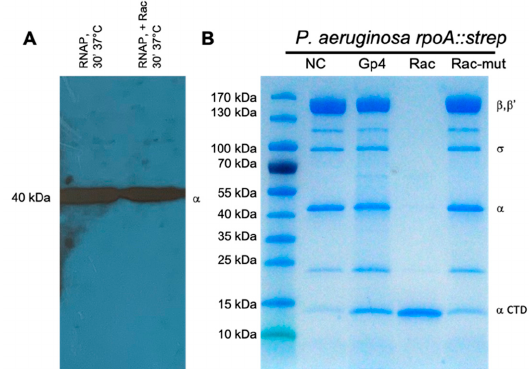
Figure A4. Rac does not have protease activity and the predicted N -acetyl CoA binding pocket of Rac is required for cleavage. ( A ) Recombinant Rac was incubated at 37 ◦ C for 30 min with P. aeruginosa RNAP purified using the RpoA-Strep tag. Western blot using antibody specific for the intact α RNAP subunit shows the α subunit is not cleaved. ( B ) The RpoA-Strep was purified from P. aeruginosa cultures 30 min after induction of Gp4 (control), wildtype Rac or mutated Rac (with an inactivated acetyl-CoA binding pocket). The wildtype rpoA::strep mutant was used as a negative control. After RpoA-Strep purification and separation on a 4–20% SDS-PAGE gel, it is clear that only the wildtype Rac provokes the α subunit